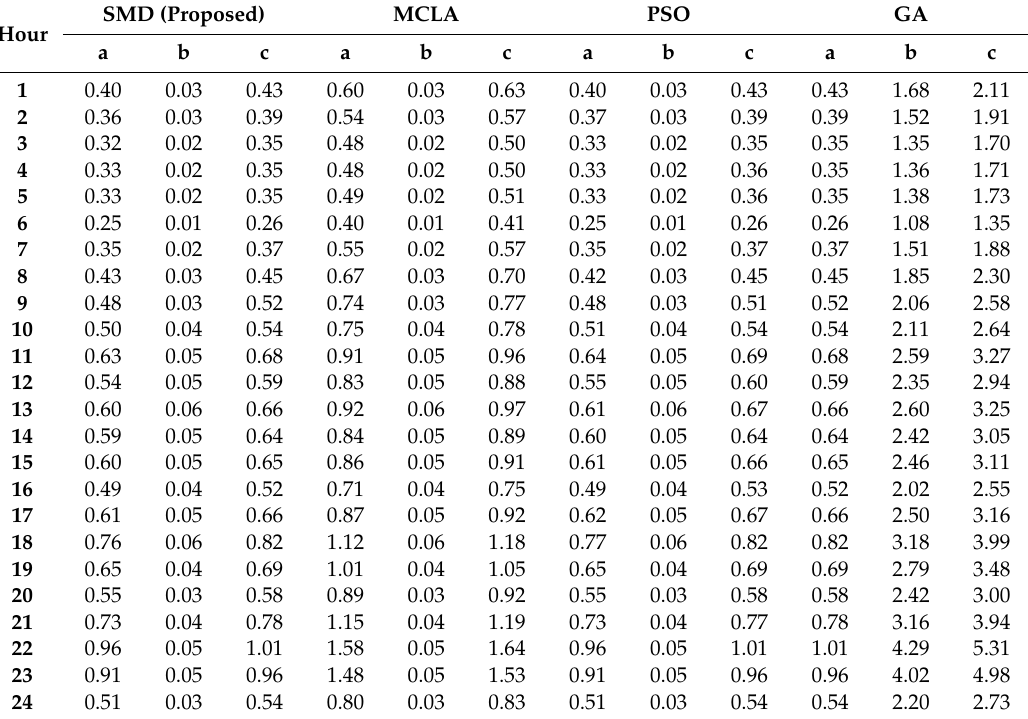
Table A4. Comparison between the hourly power losses calculated with di ff erent algorithms, [kWh].